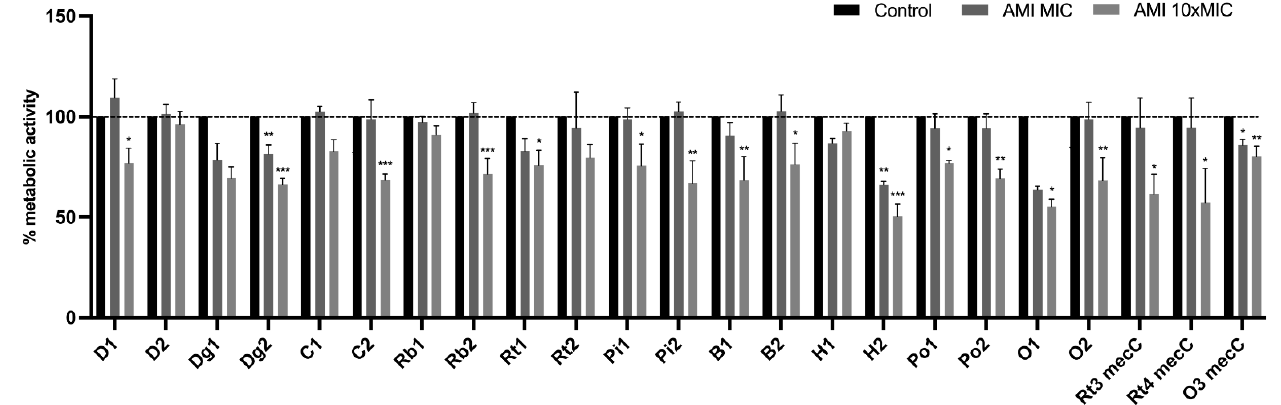
Figure 9. Metabolic activity of S. aureus biofilms before and after treated with amikacin at concen- trations of MIC and 10× MIC. The results are expressed as percentage of metabolic activity. Statisti- cal significance was determined using Dunnett ’ s multiple comparison test (* p < 0.05; ** p < 0.01; *** p < 0.001). D: donkey; Dg: dog; C: camel; Rb: rabbit; Rt: rodent; Pi: pig; B: bovine; H: hare; Po: poultry; O owl.